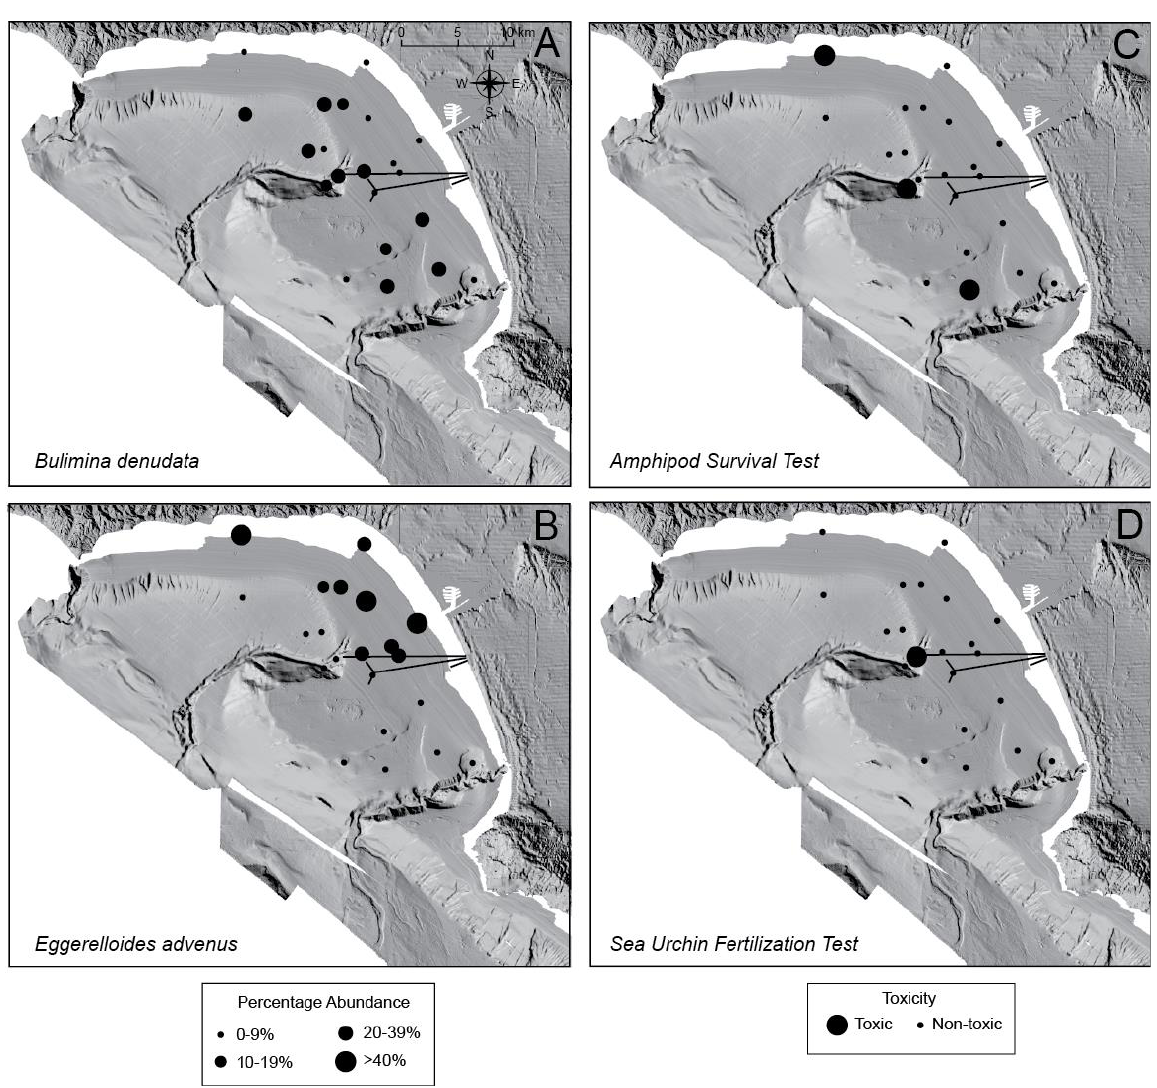
Figure 4 Figure 4. Side-scan sonar image of Santa Monica Bay, showing the percent abundance of ( A ) Bulimina denudata and ( B ) Eggerelloides advenus , as well as sediment toxicity based on ( C ) amphipod survival and ( D ) sea urchin fertilization success in surface sediments obtained in Santa Monica Bay in 1997. See Appendix A for